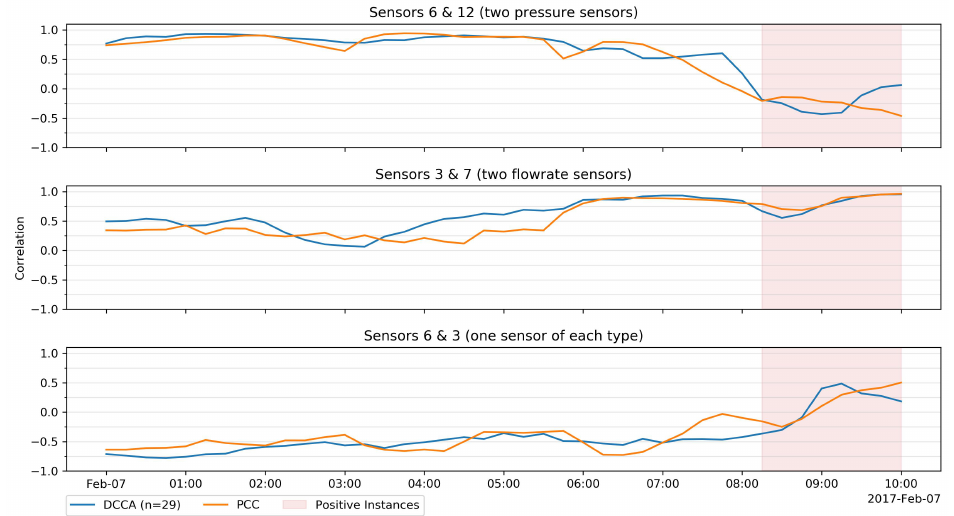
Figure 11. DCCA and PCC over time in three selected pairs from 7 February 2017, using a time window of 120